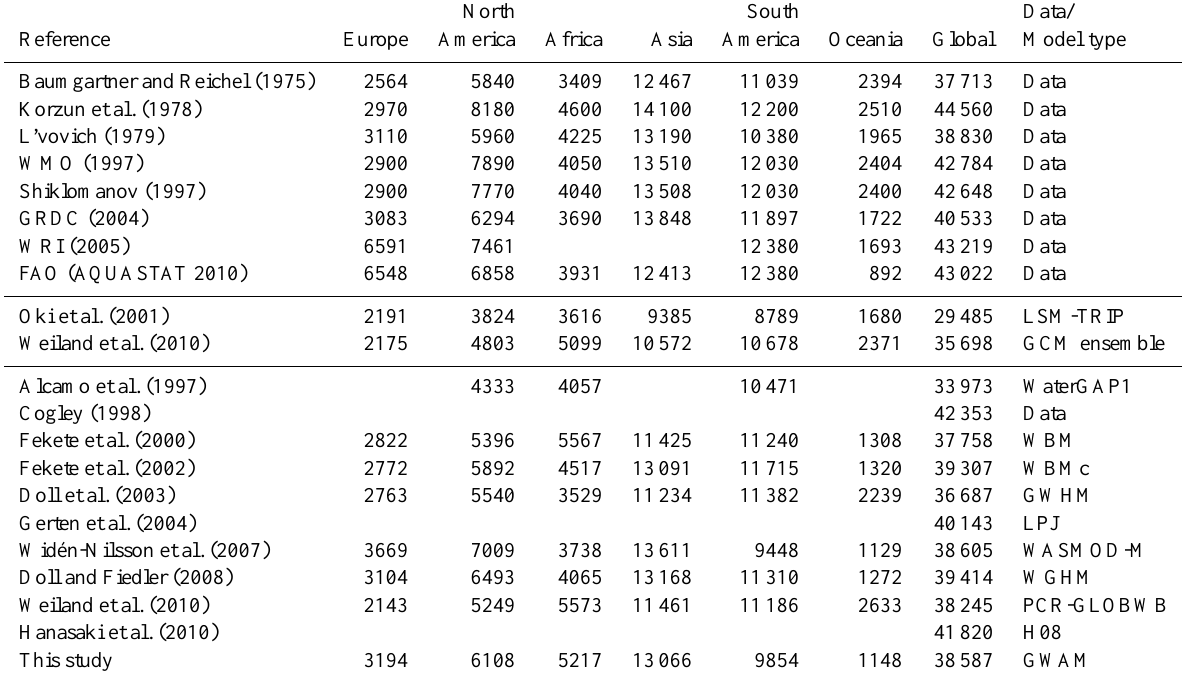
Table 1. Summary of literature estimates of global mean annual runoff using both models and data-based estimates at both the global and continental